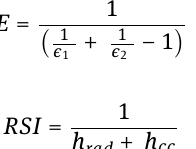
smaller non-ventilated attic space in comparison with con- crete and clay tile roofs. Metal roofs are commonly insu- lated against sound and heat using insulation materials such as mineral wool and fiberglass, supported by reflec- tive insulation material as illustrated in Figures 3 and